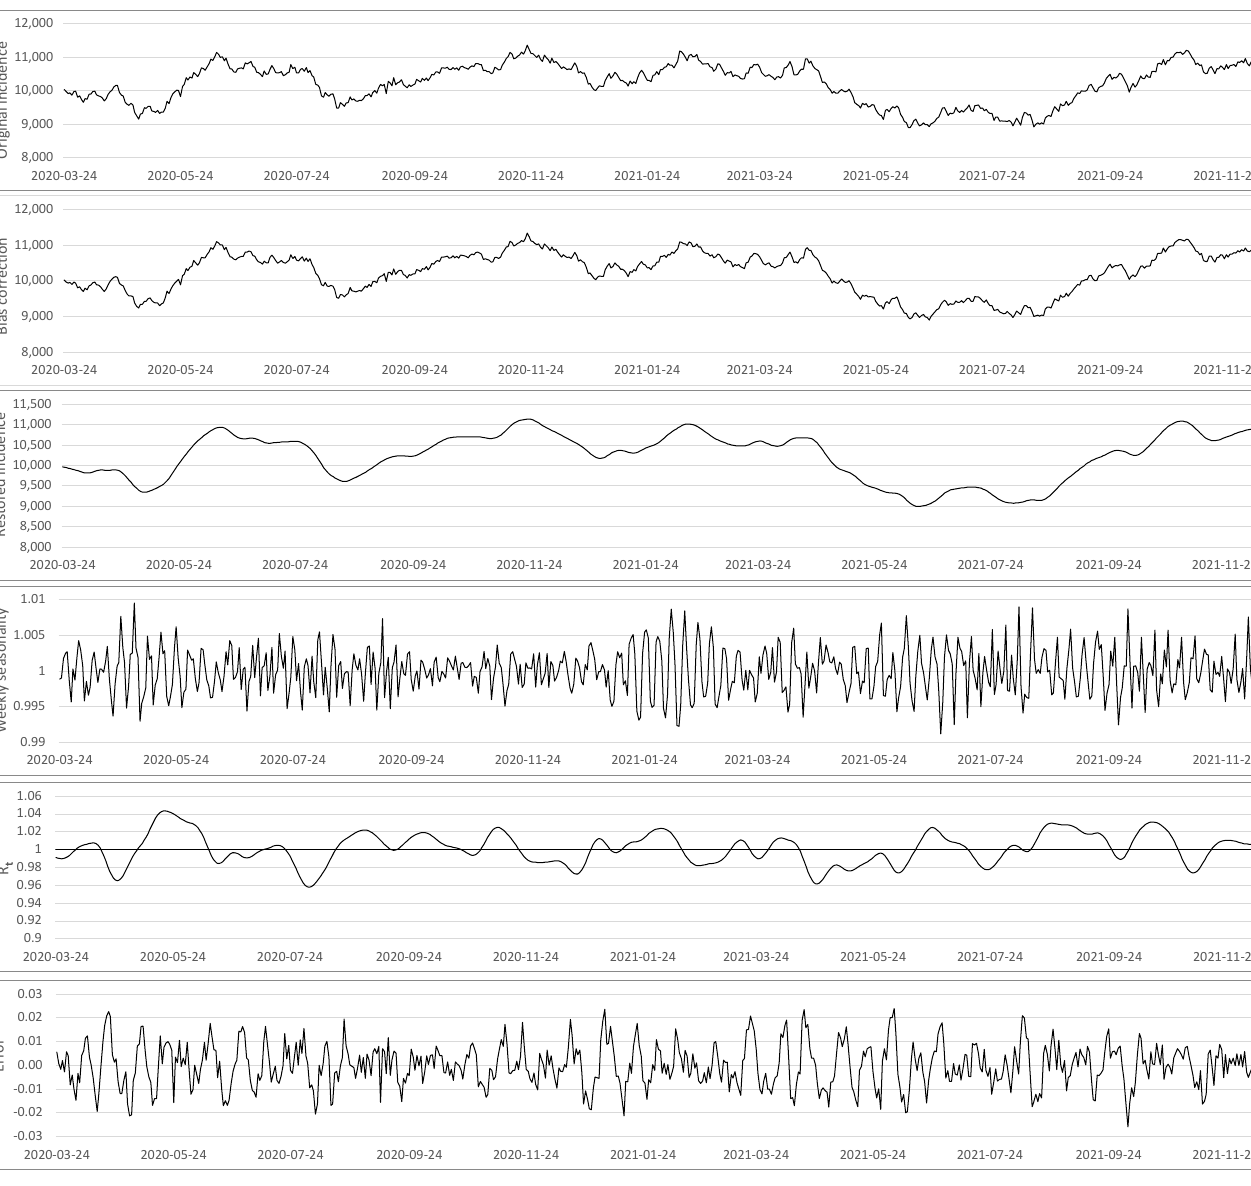
which is a Brownian t